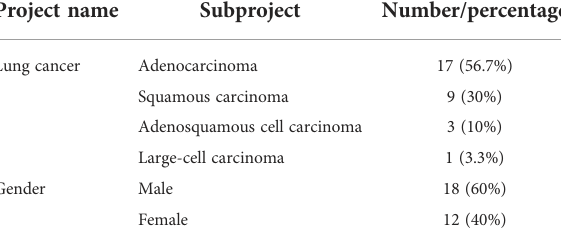
TABLE 1 Information on lung cancer samples used for library screening.